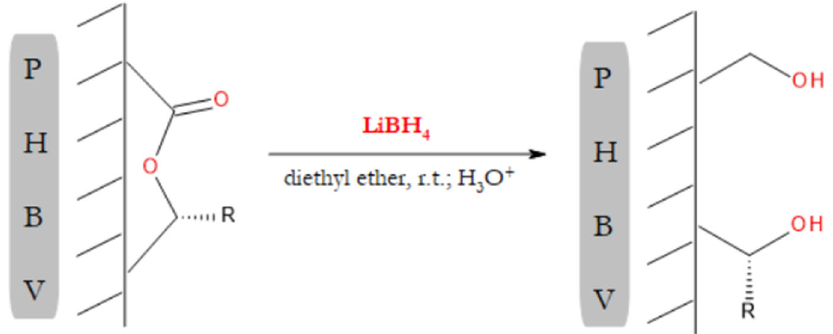
Figure 1. Scheme illustrating the modification of PHBV surface using LiBH 4 . The surface hydroxyl groups were generated through the reduction of the backbone ester groups: R = CH 3 or C 2 H 5 .